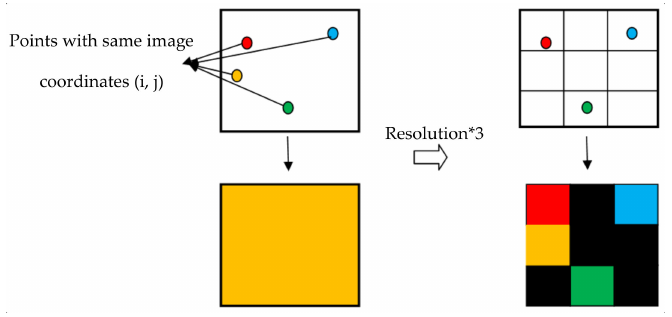
Figure 18. Influence of resolution in preserving the informational richness of cloud points.